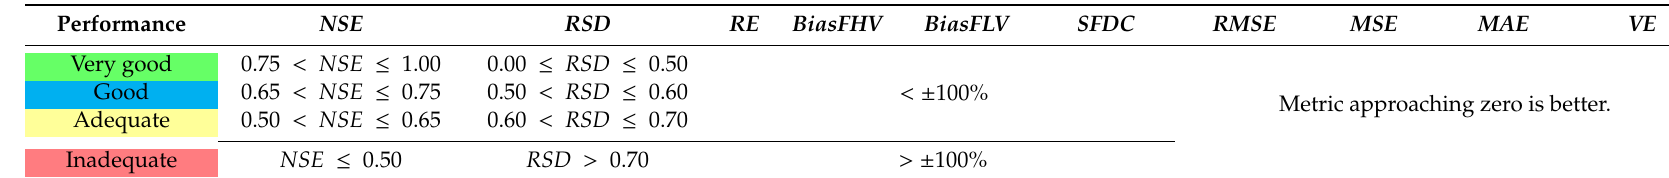
Table 2. Performance of the metrics